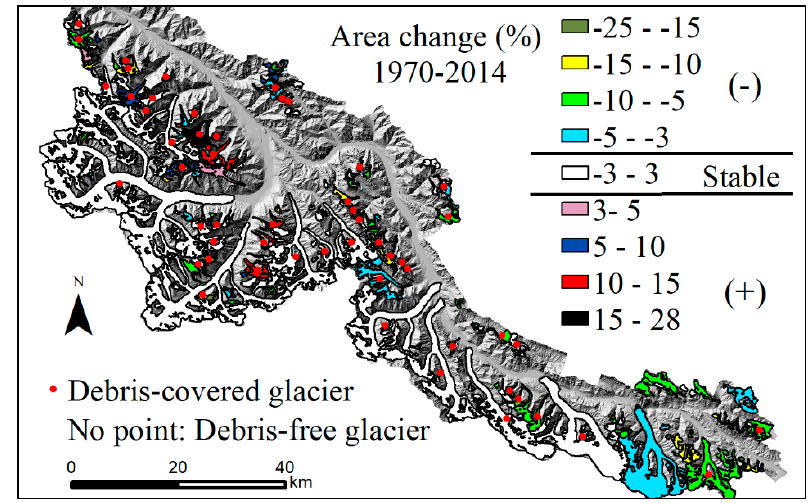
Figure 8. Glacier area change rate during 1970–2014 (( − ): decreased in area, ( + ): increased in area).